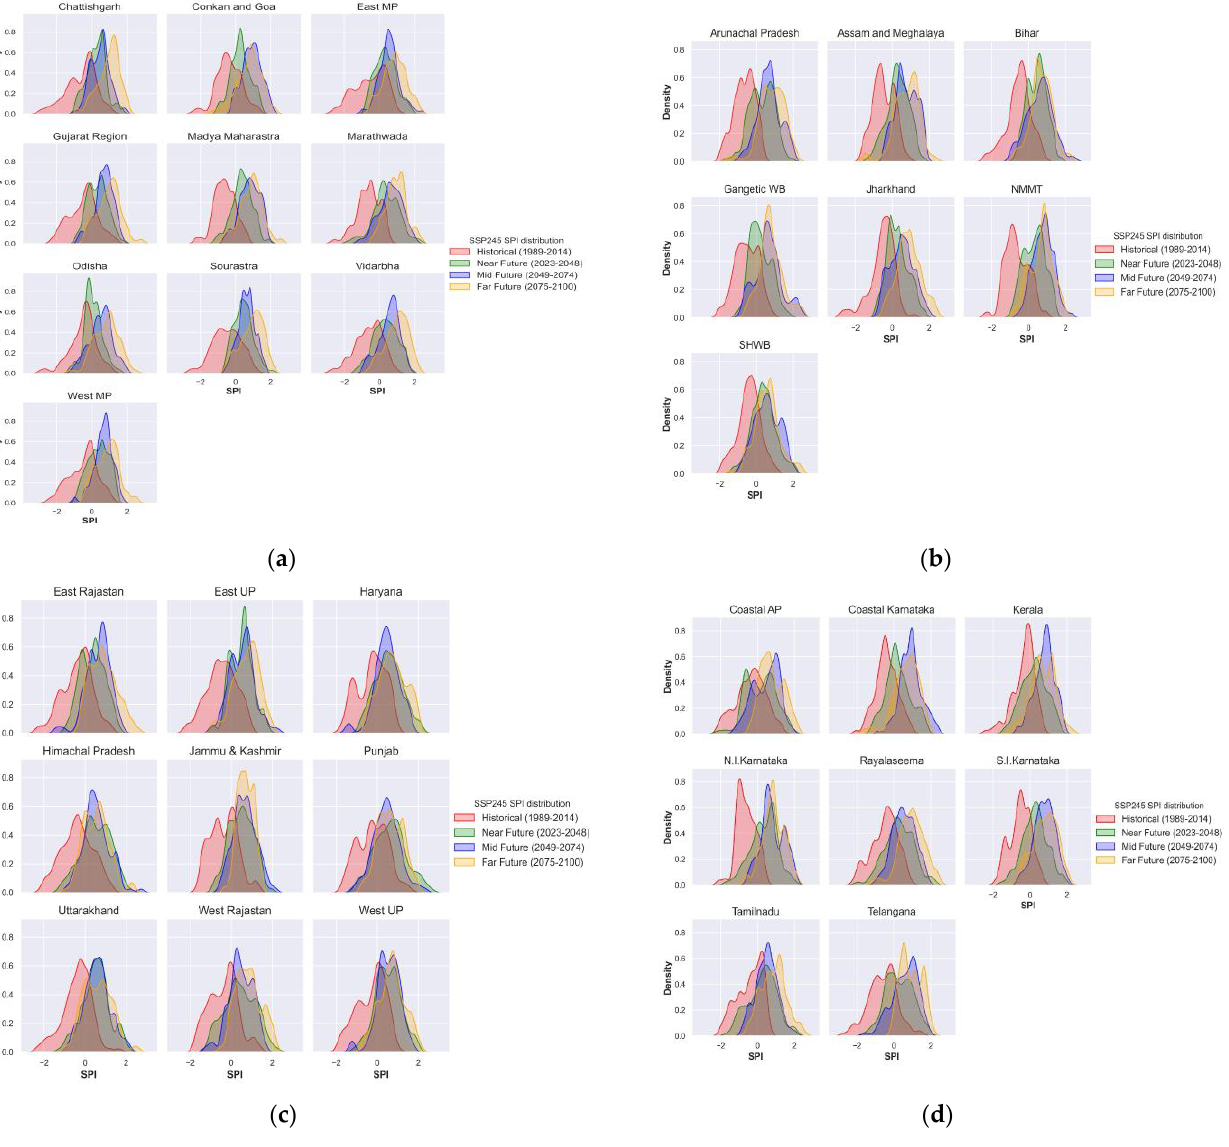
Figure 11. CMIP6 SSP245 scenarios 12-month Standard Precipitation Index (SPI) PDF plot at meteorological subdivision level ( a ) Central India, ( b ) East and Northeast India, ( c ) Northwest India, and ( d ) South Peninsula India for near, mid, and far future.